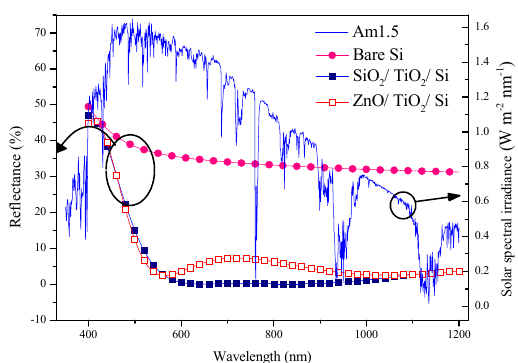
Fig. 4 . Calculated re fl ection characteristics for the AR1 and the AR2 coatings as a function of wavelength and the spectral irradiance of the AM1.5 .